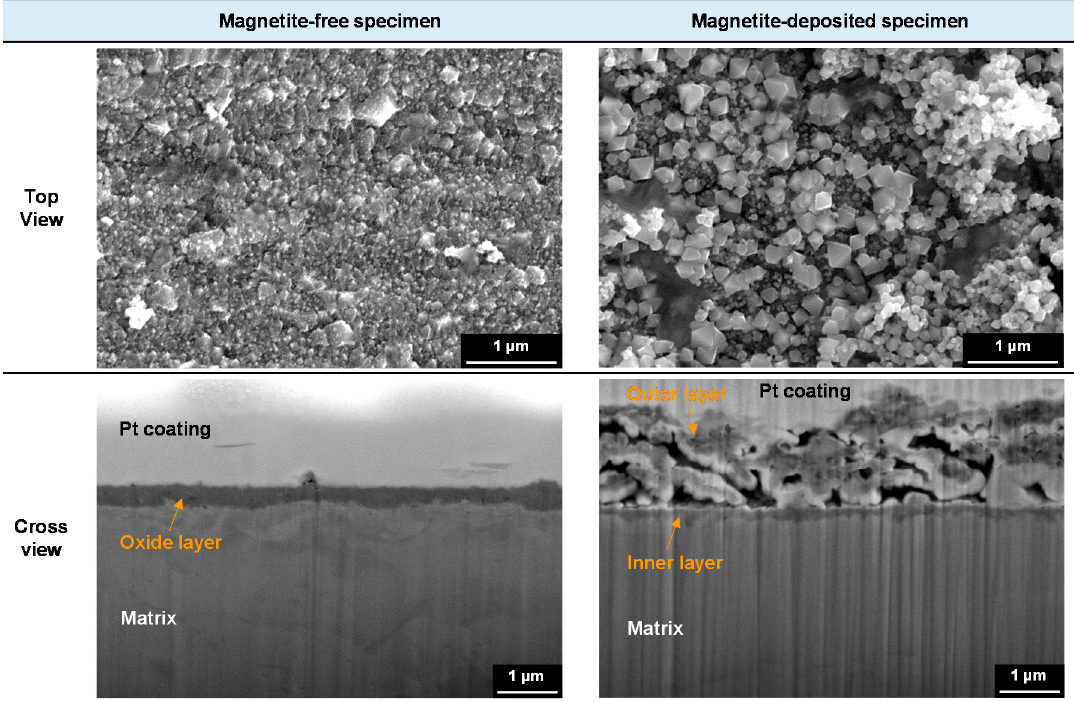
Figure 6. Corrosion morphologies of SA508 exposed to reference solution with 0.01 M sulfate ions for 100 h.